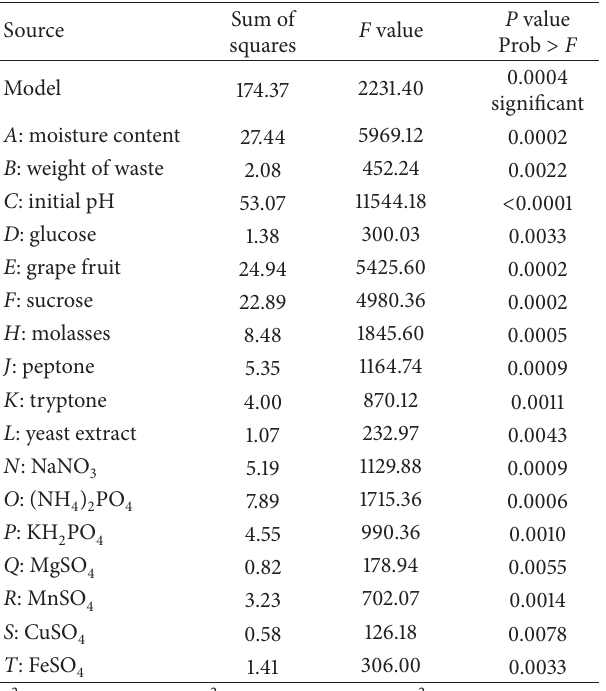
Sum of P value df F value squares Prob > F